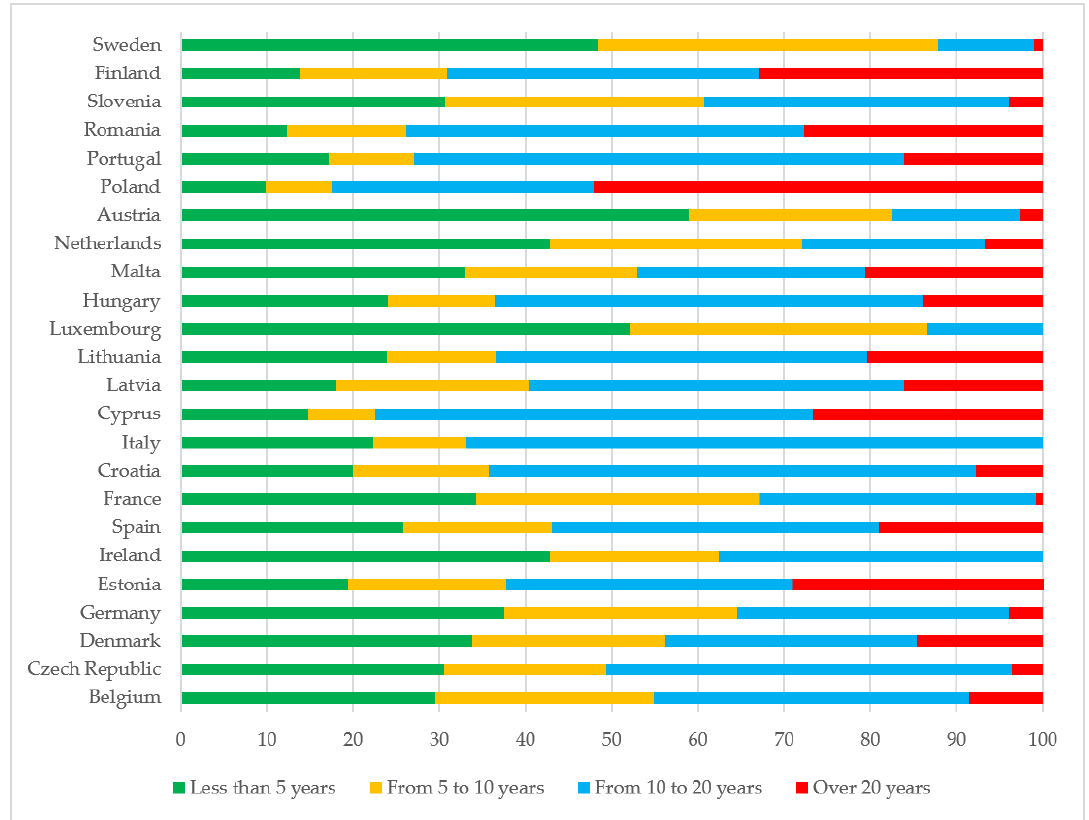
data for Bulgaria, Greece and Slovakia are not available. Source: [74].